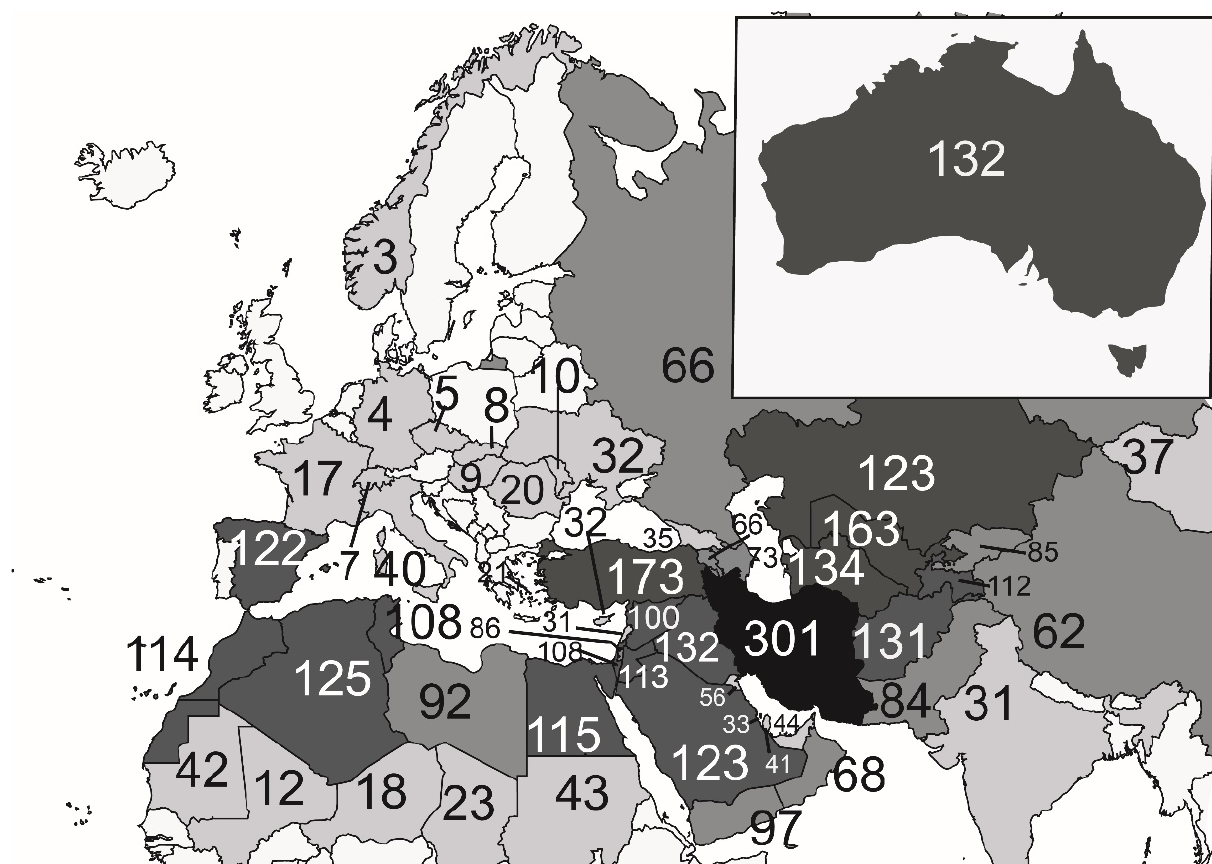
Figure 2. Number of gypsophytes and gypsoclines in the countries of the study area.Color scale: black (> 200), dark grey (199-100), medium grey (99-50) and light grey